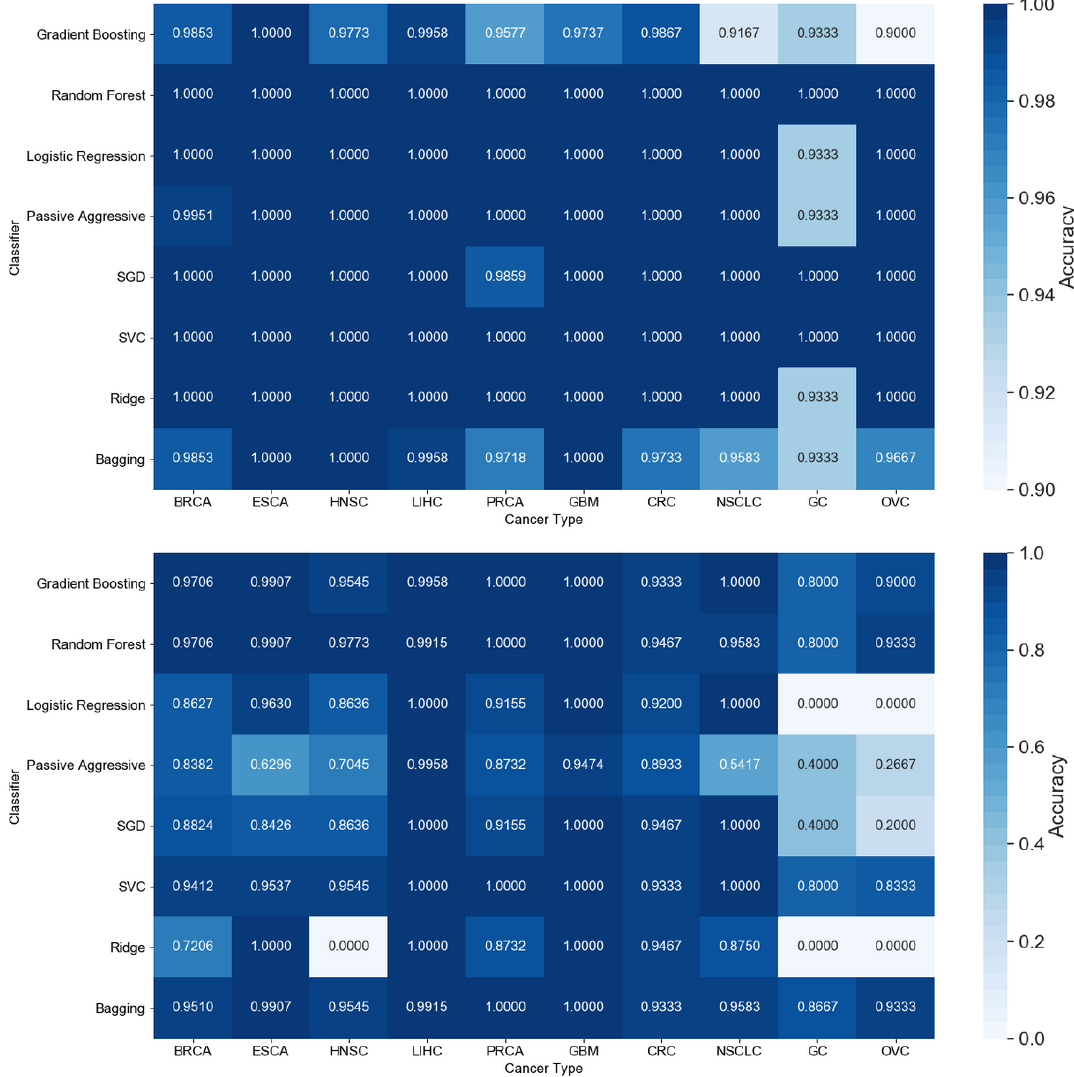
Figure 4. Comparison of accuracy by classifier and tumor type for all 253 features (top) and the 5 features identified by the proposed approach (bottom). Cancer types: breast (BRCA); esophageal (ESCA); head and neck squamous cell (HNSC); liver hepatocellular (LIHC); prostate (PRCA); gliobastoma (GBM); colorectal (CRC); non-small-cell lun g (NSCLC); gastric (GC); ovarian